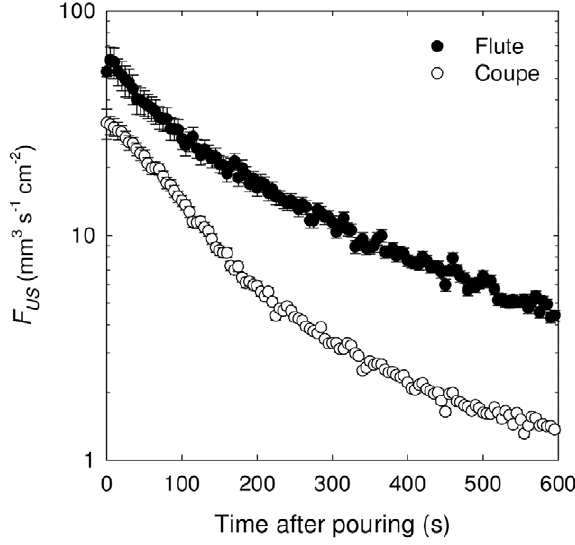
Figure 5. CO 2 volume fluxes desorbing from a flute and a coupe. CO 2 volume fluxes per unit surface (in mm 3 s 2 1 cm 2 2 ) desorbing from a flute and a coupe, respectively filled with 100 mL of champagne (for a bottle stored at 20 u C), all along the first 10 min following the pouring process (redrawn from Liger-Belair et al. [33]).